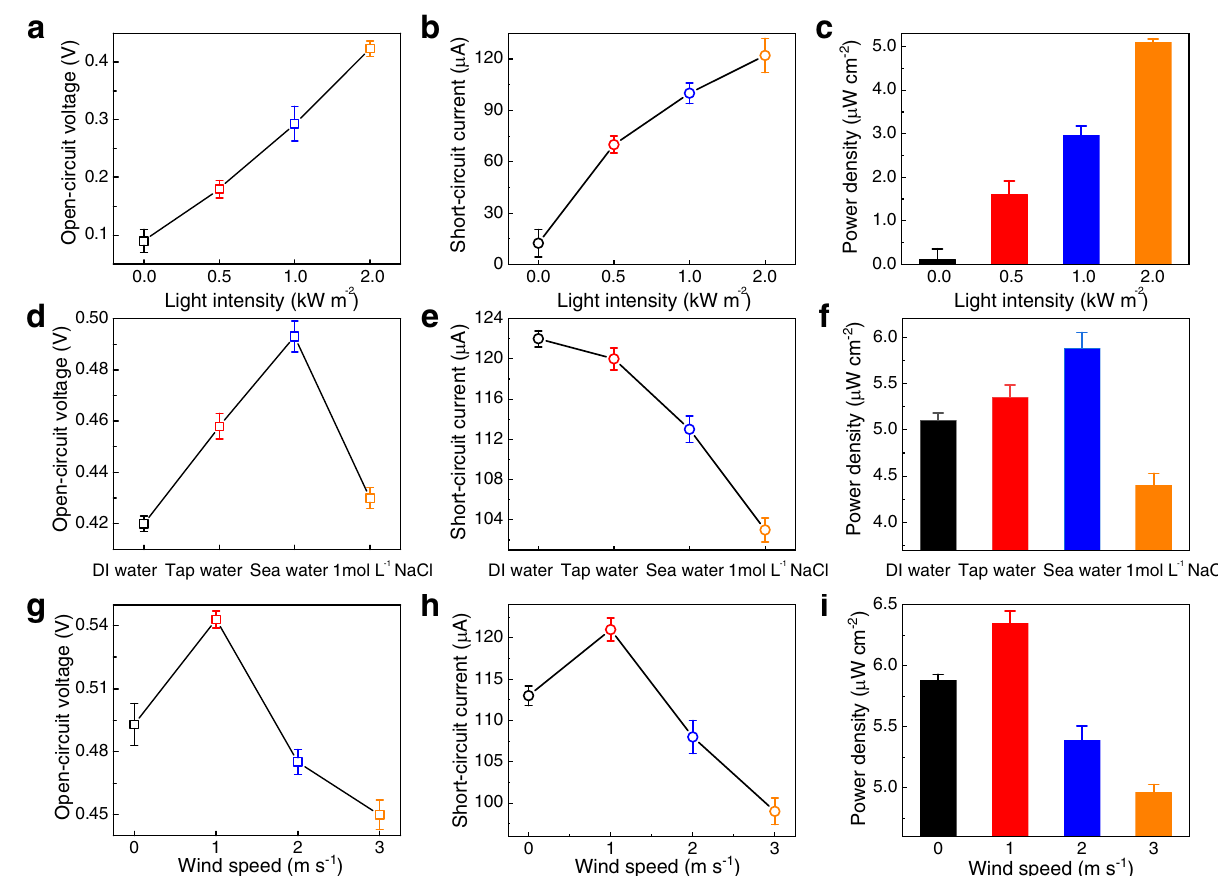
Fig.4|PowergenerationperformanceoftheIENGunderdifferentsurrounding conditions. a – c Power generation performance of the IENGs under different light intensities. d – f Power generation performance of the IENGs in different liquids.